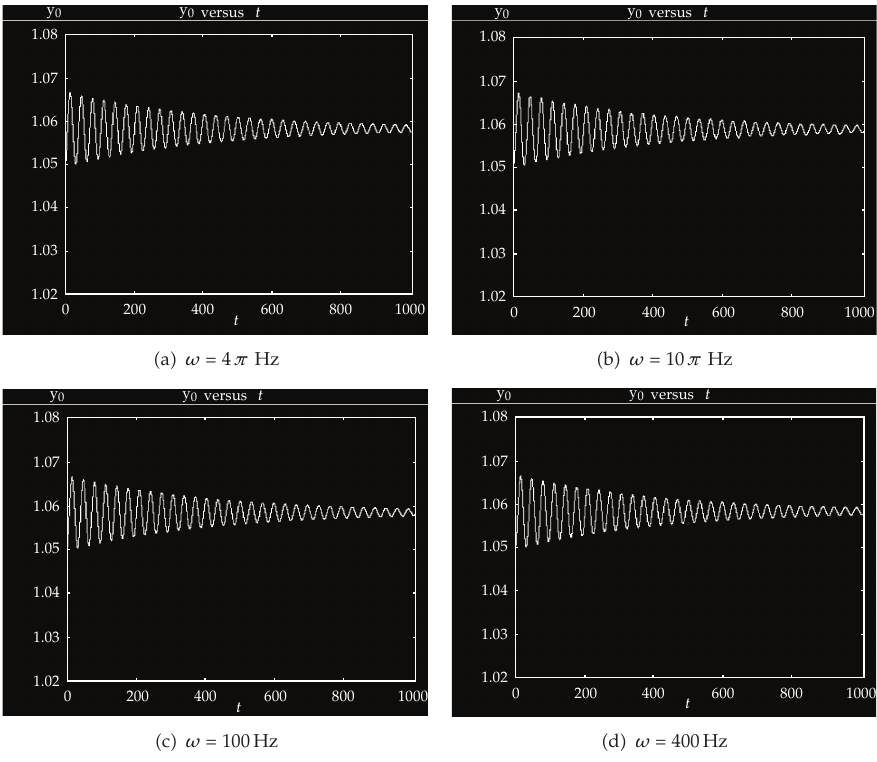
Figure 7: Stretch ratio with varying ω